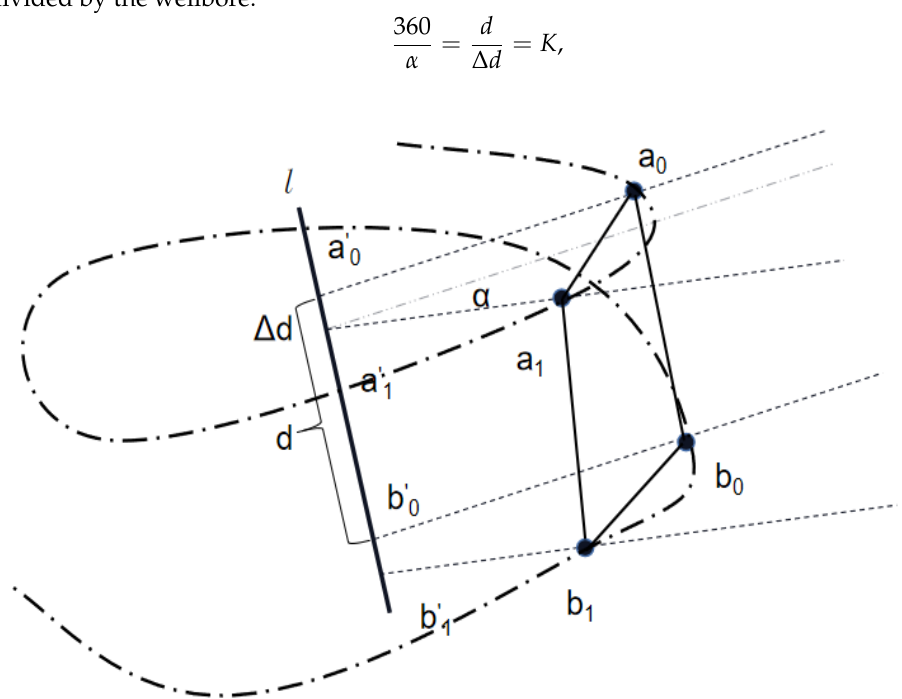
Figure 4. Four points on the spiral contour line constitute a quadrilateral in space. The quadrilateral obeys the following rules on the spiral contour: Rule 1 On two adjacent spiral lines, the included angle of rotation around the axis line from 0 a to 1 is the same as the included angle of the rotation around the axis line from 0 with a magnitude of , that is, the angles between adjacent points on the pitch are equal.